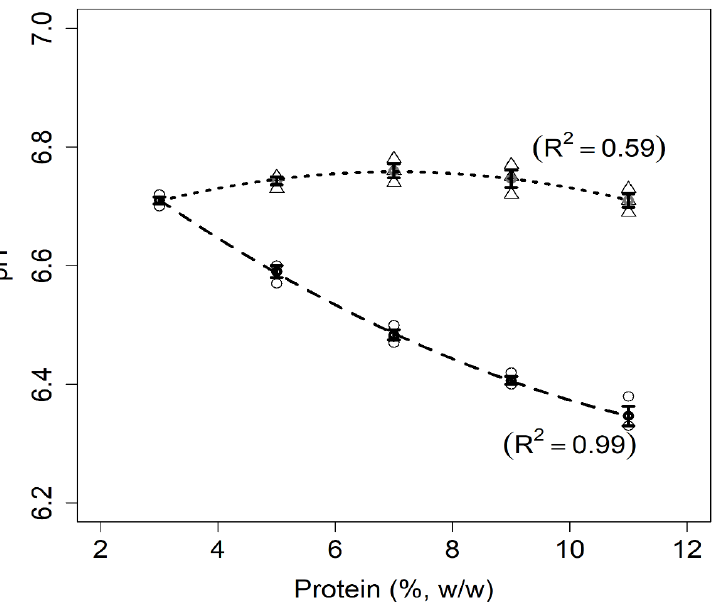
Figure 1. Relationship between pH and protein concentrations for milk (dashed line) and mixed protein (dotted line) samples. The figure shows the data points for milk (circles) and mixed samples (triangles), error bars (SE), fitted curves, and adjusted coefficients of determination (R 2 ).